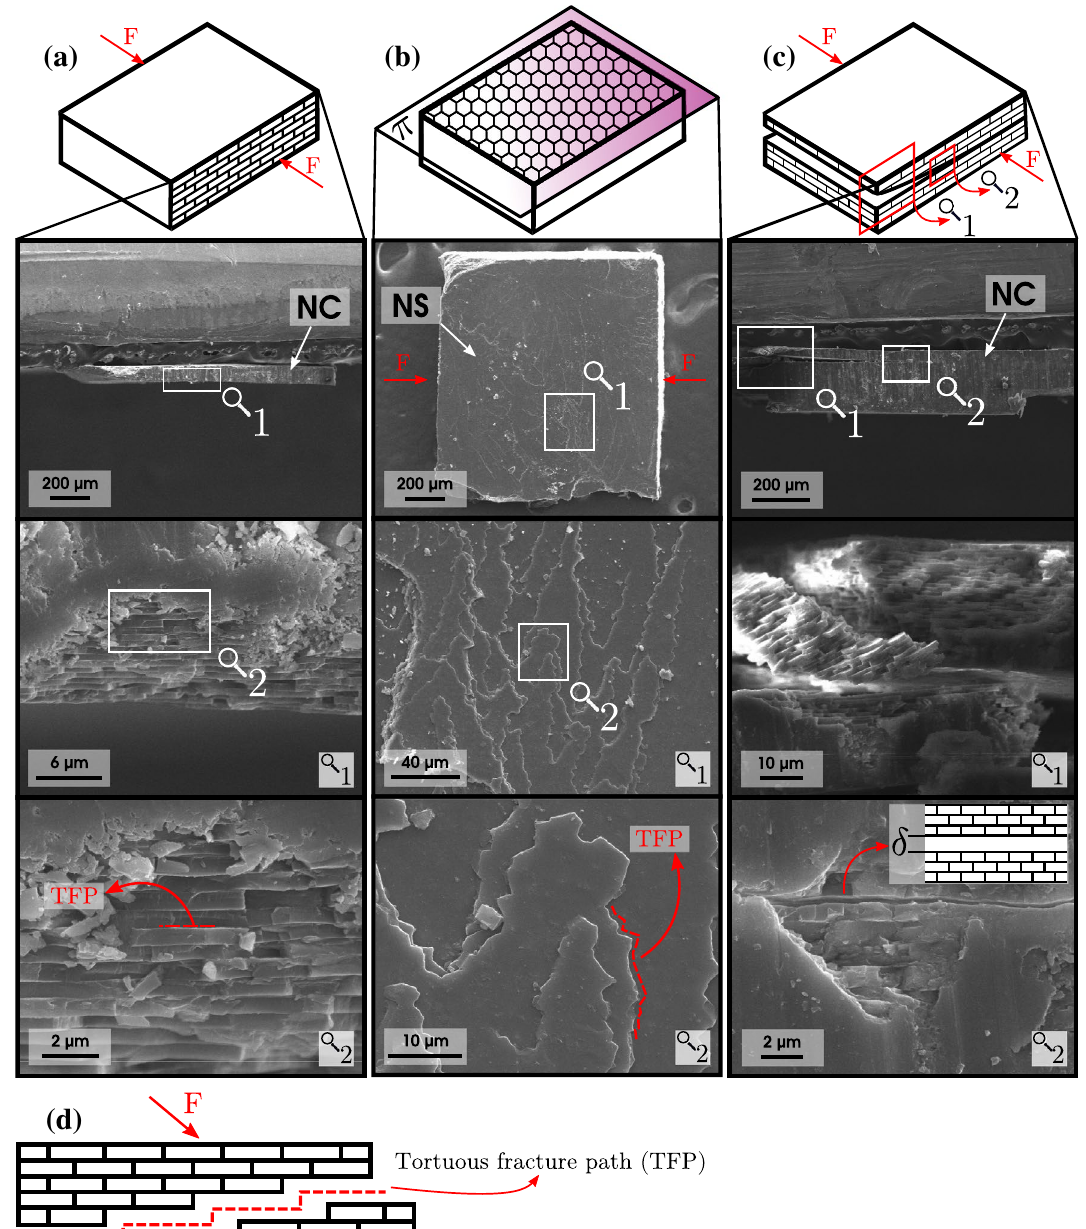
Figure 6. SEM images of the samples at the end of the compression test in the longitudinal ( ddd l ) and transversal ( ddd tr ) directions. ( a ) imaging on the layer cross-section (NC), ( b ) Imaging on the nacreous layer surface (NS), ( c ) sample with incomplete delamination, whose fracture origin has an aragonite “bricks” separation of δ , ( d ) tortuous fracture path (TFP). F: direction of the applied force; π : delamination